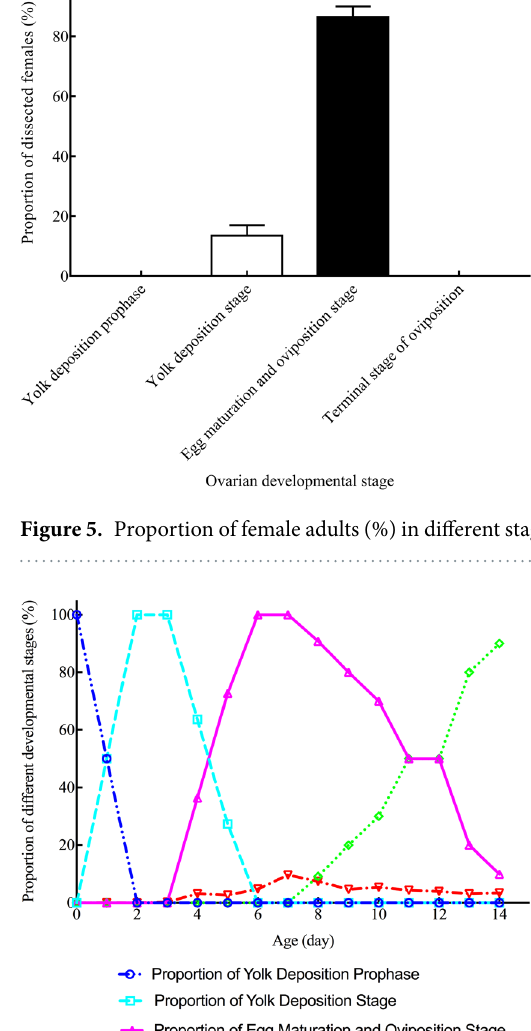
Different ovarian developmental stages Best-fit equation